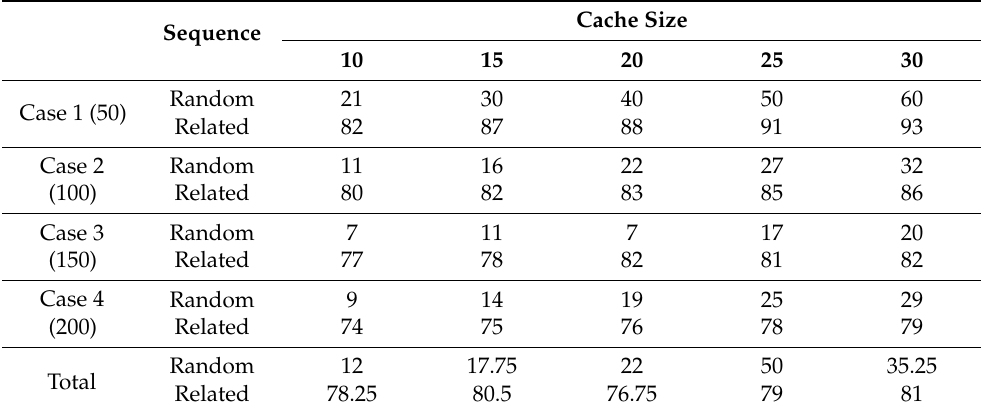
Table 4. Average hit ratio of all cases in random and related-question sequence.